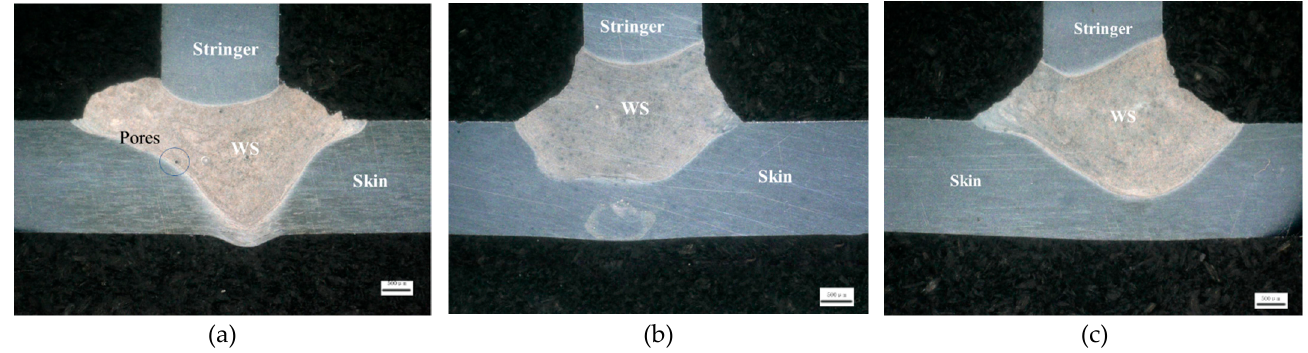
Figure 2. Macro morphology of T-joint and the proportion of weld penetration. ( a ) sample 1, ( b ) sample 2, ( c ) sample 3.